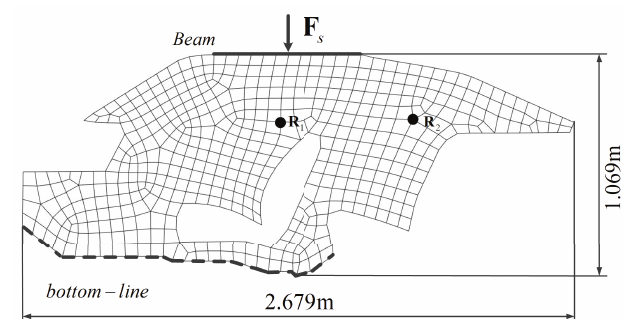
Figure 7. 2D interior-car vibro-acoustic